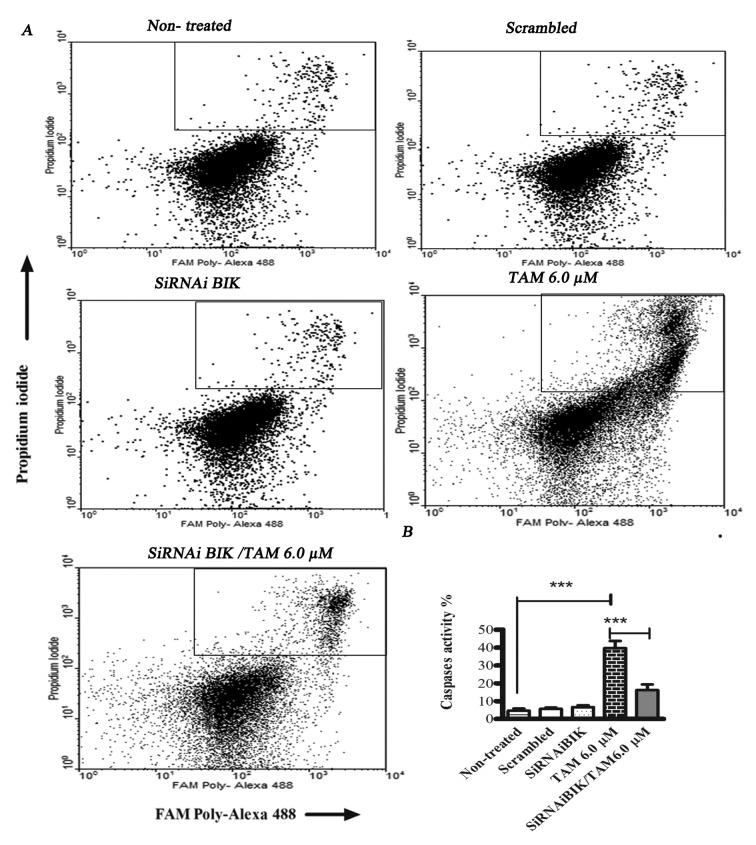
Suppression of the Bik gene promotes resistance in the process of apoptosis. (A) For corroborate apoptosis MCF-7 cells were stained with Annexin V-FITC and PI and analyzed by flow cytometry. (B) Representative graphic of fluorescence intensities for apoptosis. Results are representative of three independent experiments. The groups were analyzed by one-way ANOVA with the Tukey’s test. *p<0.05; **p<0.01; ***p<0.001 vs. non-treated. Representative figures of three independent experiments carried out in triplicate are shown.